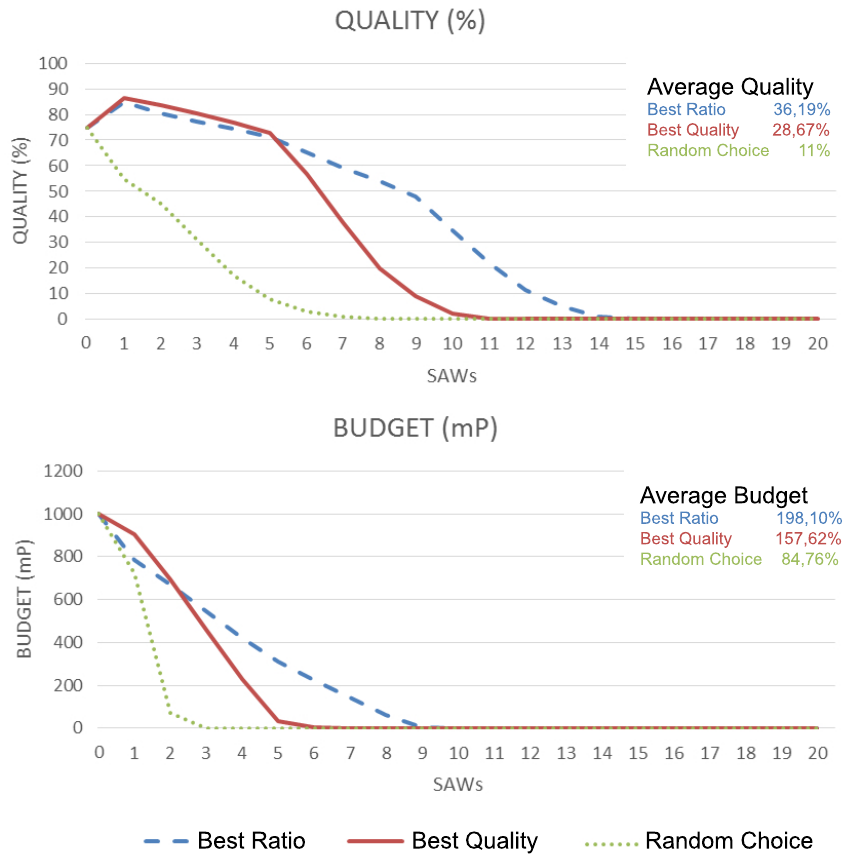
Figure 2. DPB results under medium budget